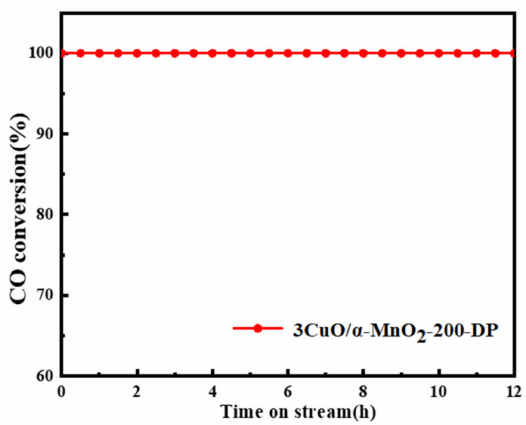
Figure 11. Stability of 3CuO/ α -MnO 2 -200-DP catalyst at 80 ◦ C for 12